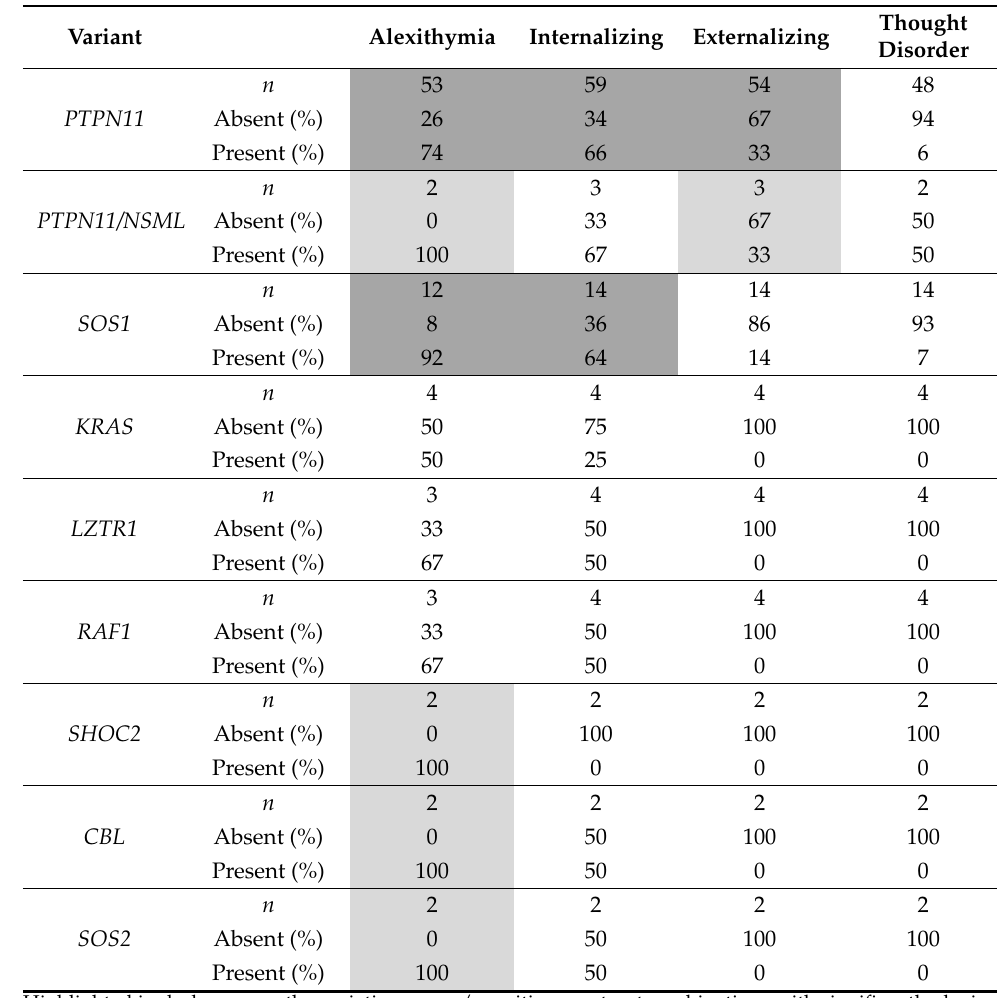
Highlighted in dark grey are the variation group/cognitive construct combinations with significantly deviant performances; highlighted in light grey are the variation group/cognitive construct combinations that show a trend towards deviant